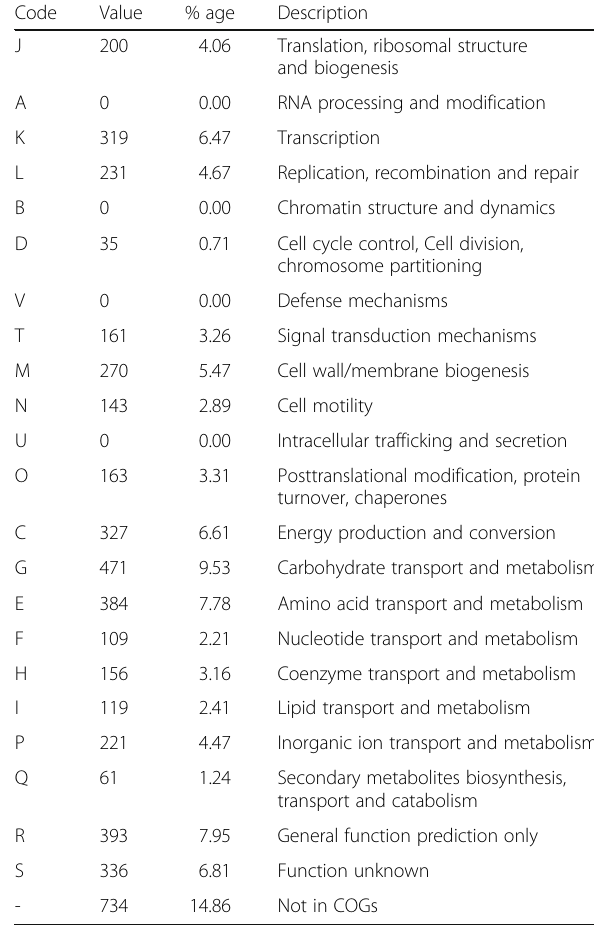
Table 5 Number of genes associated with general